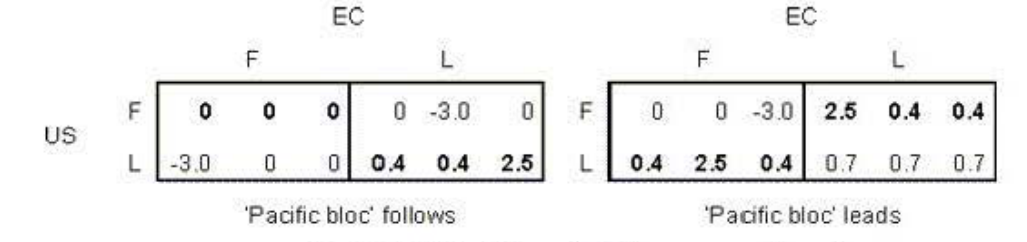
Table 8.2 Prediction of a future game w~h